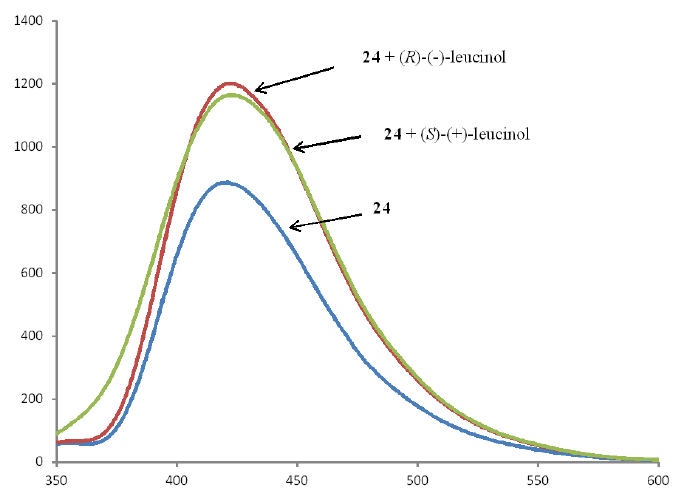
Figure 11. Fluorescence spectra of compound 24 in the presence of ( R )- and ( S )-enantiomers of tert -leucinol (1000 equiv.).